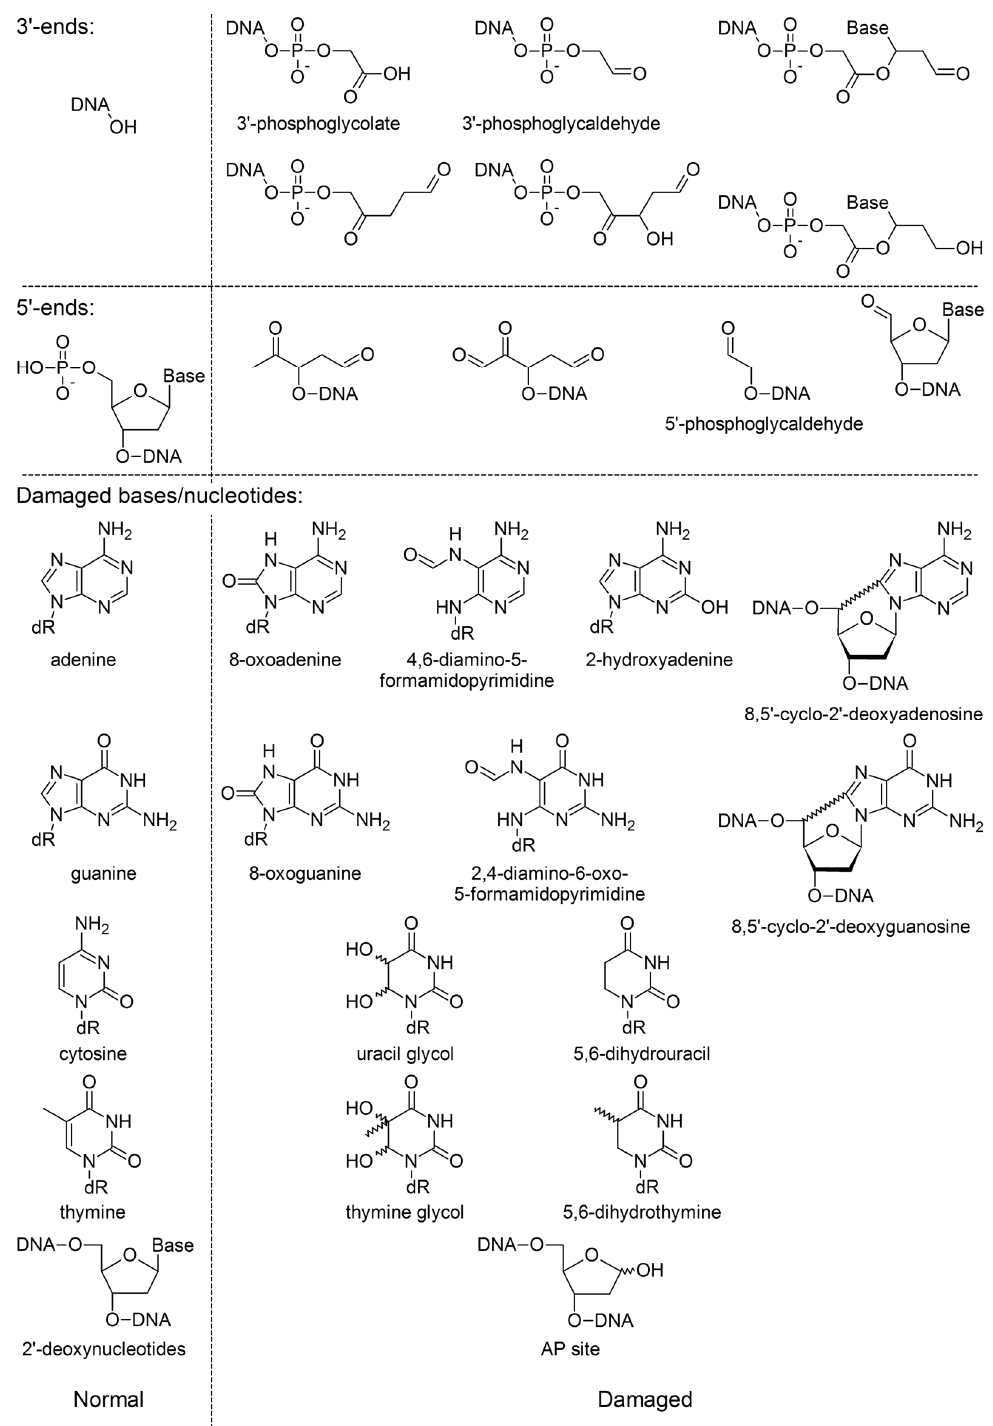
Figure 2. Structures of selected ionizing-radiation-generated DNA break ends, damaged bases, and nucleotides and their parent moieties. “Normal” 3 ′ ends are those extendable by DNA polymerases without additional enzymatic processing. “Normal” 5 ′ ends are those that can be ligated without additional enzymatic processing. In “Damaged bases/nucleotides”, for the sake of brevity, 2 ′ -deoxyribose is shown as dR, and base rather than nucleotide names are given if only the base is damaged. At present, the specifics of BNC-produced DNA damage seem to be fairly similar to other types of high-LET damage [43]. A convenient way to study BNC-induced reactions is the neutron irradiation of aqueous solutions containing boron compounds (boric acid in the simplest variant) and an appropriate target such as plasmid DNA [44–46]. Such